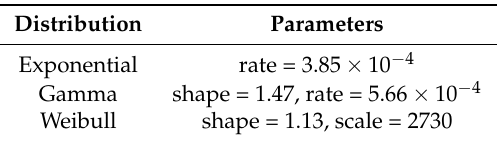
Table 1. Maximum likelihood parameters